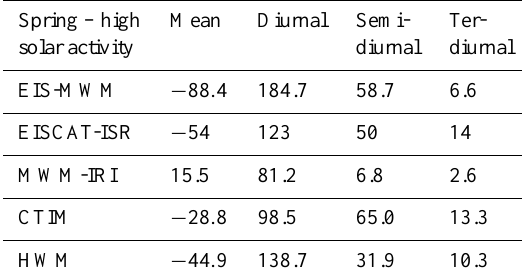
Fig. 6. As for Fig. 1 but for summer season, high solar activity. Table 6. As for Table 1 but for summer season, high solar